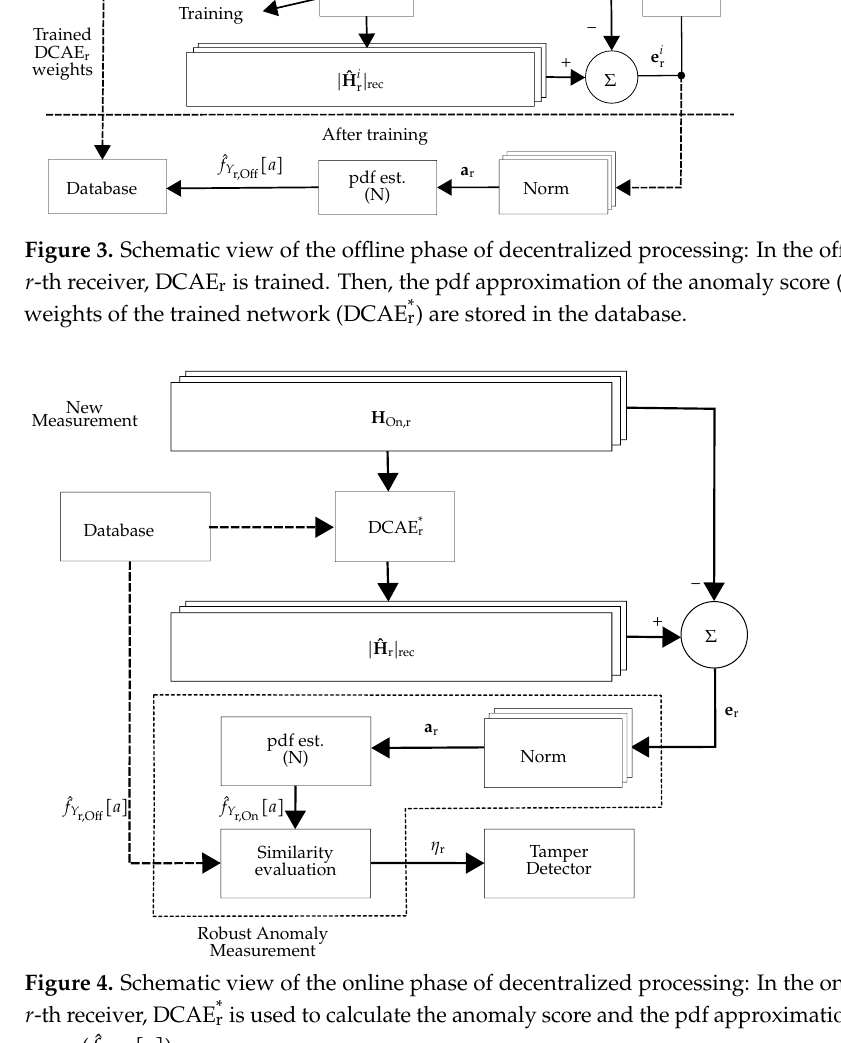
Figure 4. Schematic view of the online phase of decentralized processing: In the online phase of the r -th receiver, DCAE * r is used to calculate the anomaly score and the pdf approximation of the anomaly [ a ] score ( ˆ f Y r,On